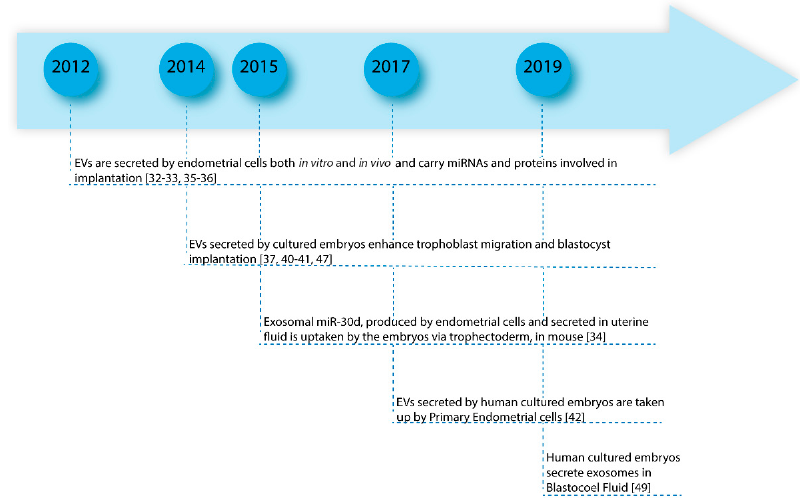
Figure 5. Milestones of the main significant papers about the involvement of EVs in embryo implantation and its early development and their potential role in negative pregnancy outcomes.